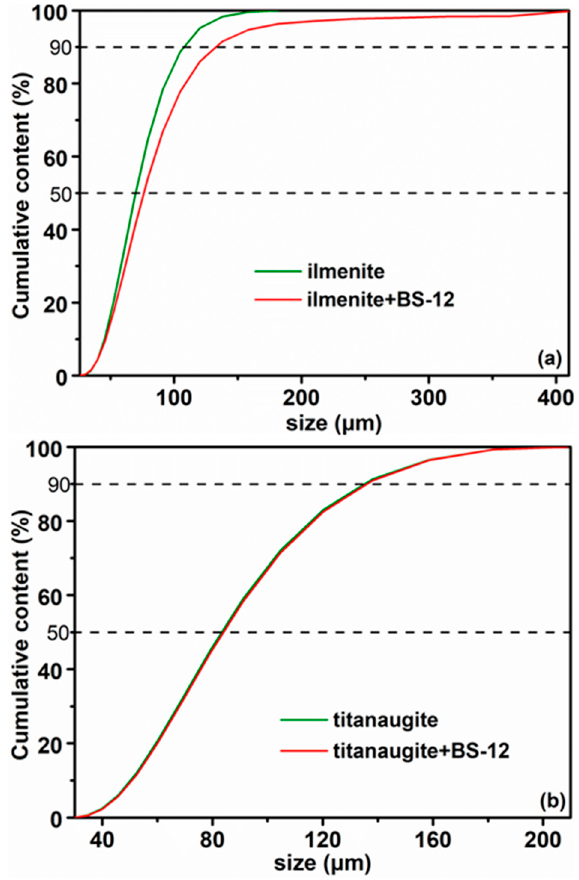
Figure 6. Particle size distributions of ilmenite ( a ) and titanaugite ( b ) in the absence and presence of BS-12 (c = 6.0 × 10 − 5 mol/L) at pH 6.